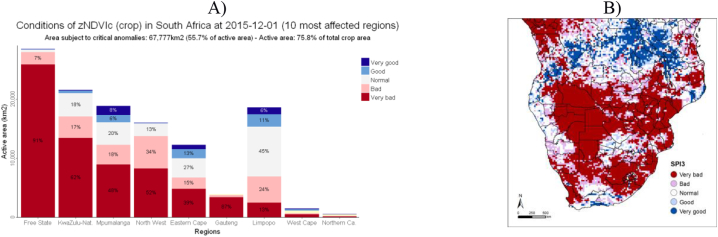
South Africa, 01 Dec. 2015. A): Active area and share of area affected by five classes of cNDVIz anomaly. B): SPI3 map. The numerical values for both legends (zNDVIc and SPI3) are: > 1 (Very good), 0.5:1 (Good), −0.5:0.5 (Normal), −1:-0.5 (Bad), and < −1 (Very bad).